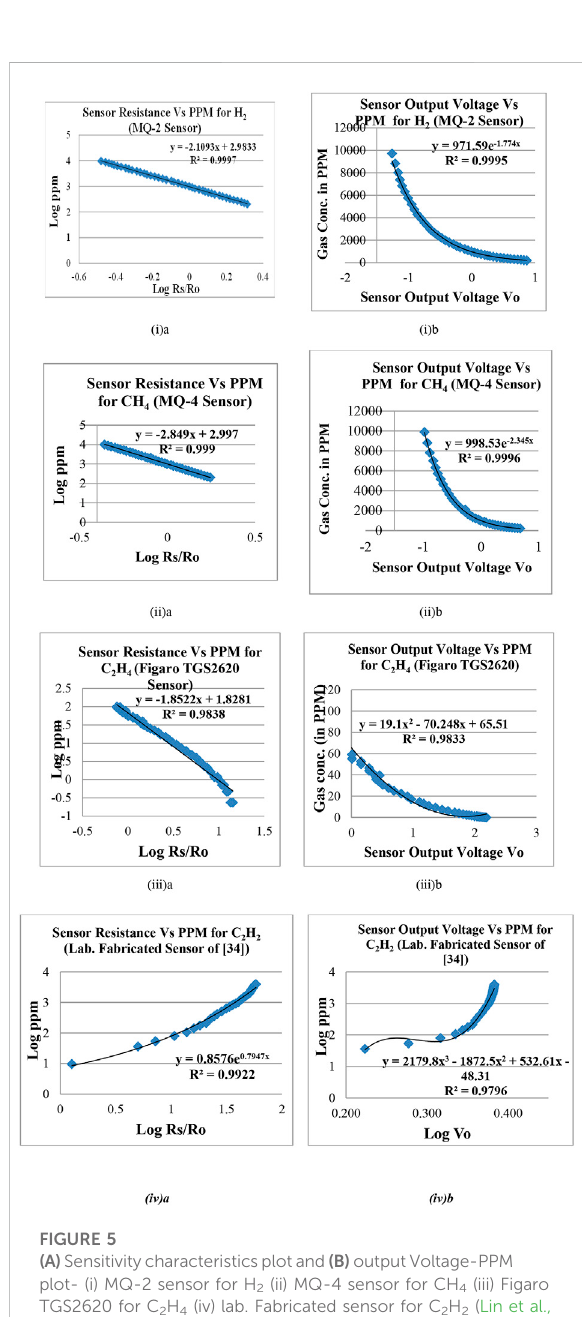
FIGURE 5 (A) Sensitivitycharacteristicsplotand (B) outputVoltage-PPM plot- (i) MQ-2 sensor for H 2 (ii) MQ-4 sensor for CH 4 (iii) Figaro TGS2620 for C 2 H 4 (iv) lab. Fabricated sensor for C 2 H 2 (Lin et